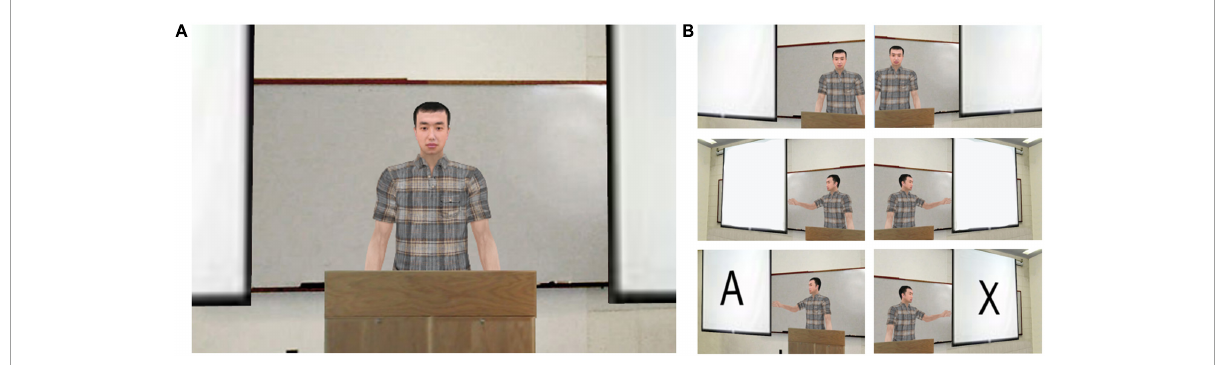
FIGURE1 Virtual reality (VR) classroom environment. VR classroom condition presented to the participants. (A) No-cue condition, in which the teacher avatar was presented in the center of the visual field without presenting any social cues. (B) The visual cue (hand gesture) provided by the teacher avatar in the visual cue condition and the visual/audio cue condition. The images are presented in chronological order; the teacher avatar gestures toward one screen, then the stimulus appears on the pointed